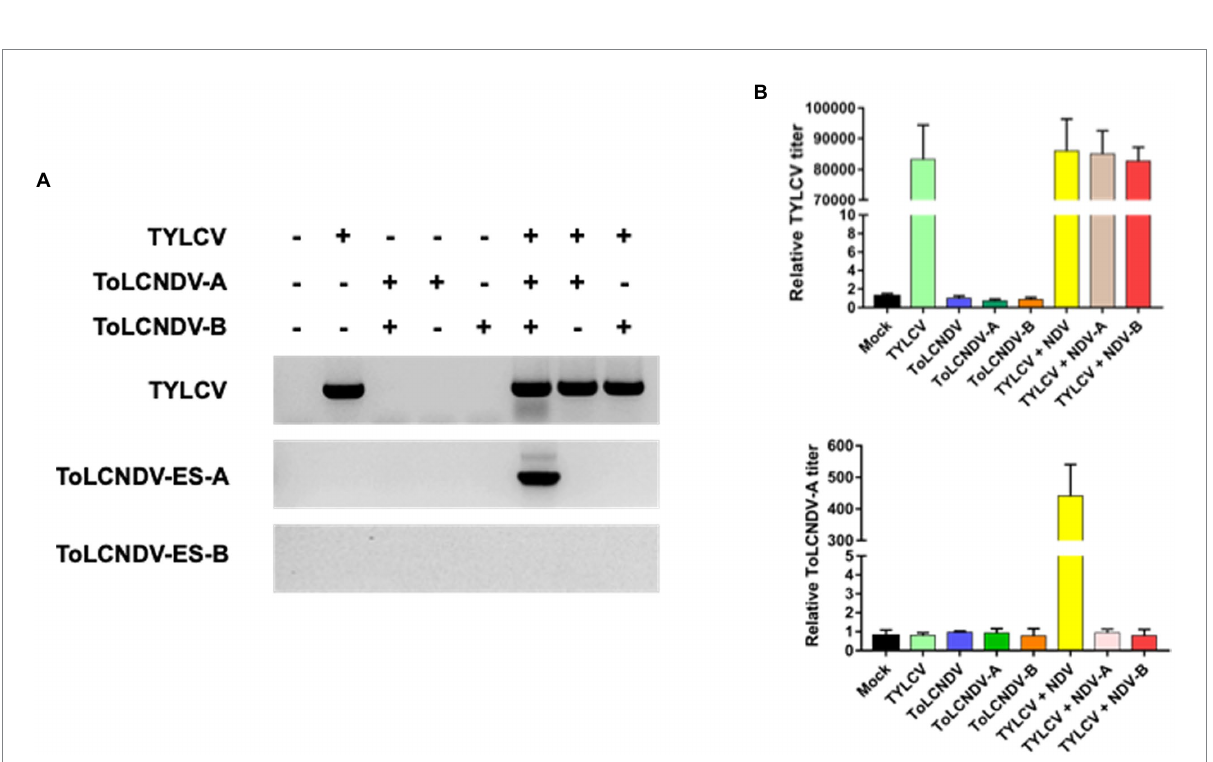
FIGURE 5 Co-inoculation result on TYLCV susceptible tomato (San Pedro cultivar): (A) PCR amplification results between TYLCV and ToLCNDV-ES component after 21 dpi. Seven mixed infections were tested at the same time under the presence (+) or absence ( − ) of different viral components. Only co-inoculated plants were positive for ToLCNDV-ES presence; (B) qPCR result for relative TYLCV and ToLCNDV-ES titers on co-inoculated plants. Titer in mock plants was normalized to 1. Relative viral titers were calculated by the 2 −ΔΔ Ct method. Statistical analysis by t -test ( p value < 0.05) indicated no significant difference in TYLCV amount among single and mixed infection plants, whereas the ToLCNDV-ES titer in co- infected tomato showed a significant